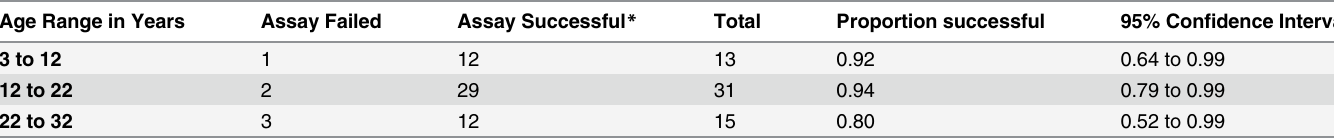
Table 5. Success of whole exome assay by formalin-fixed paraffin-embedded specimen storage time. Age Range in